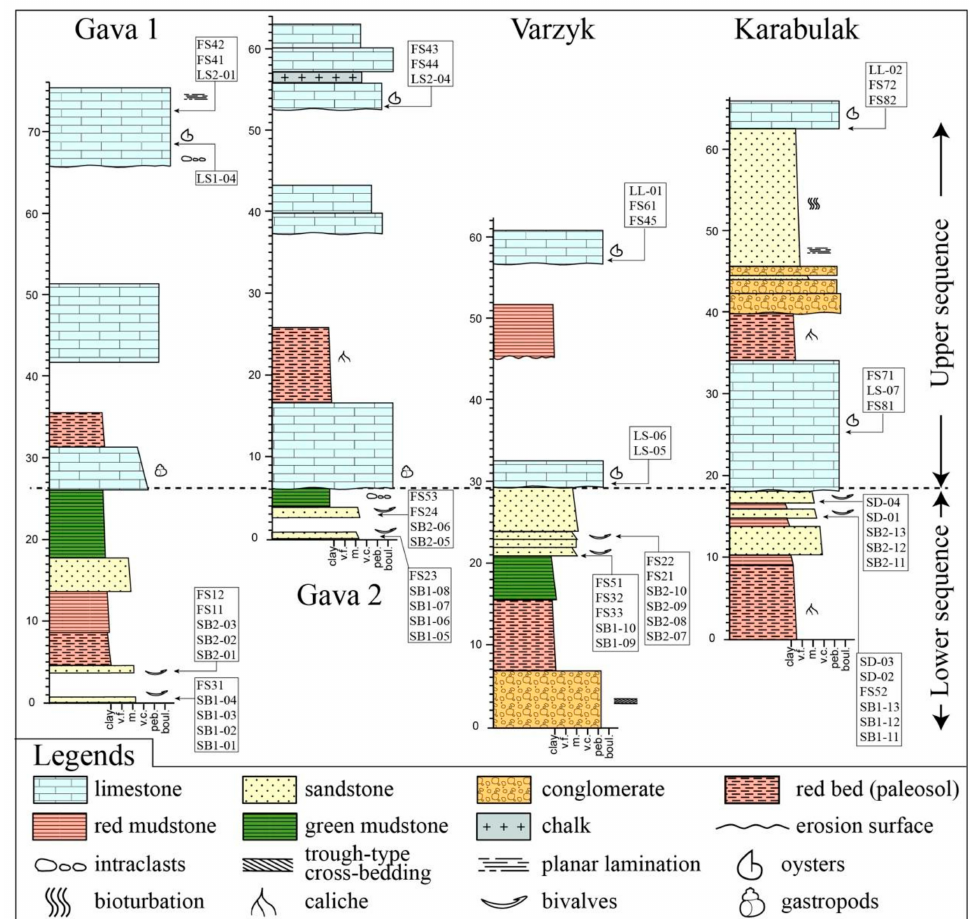
Figure 3. Columnar sections of the study area in the northern part of the Fergana Basin within